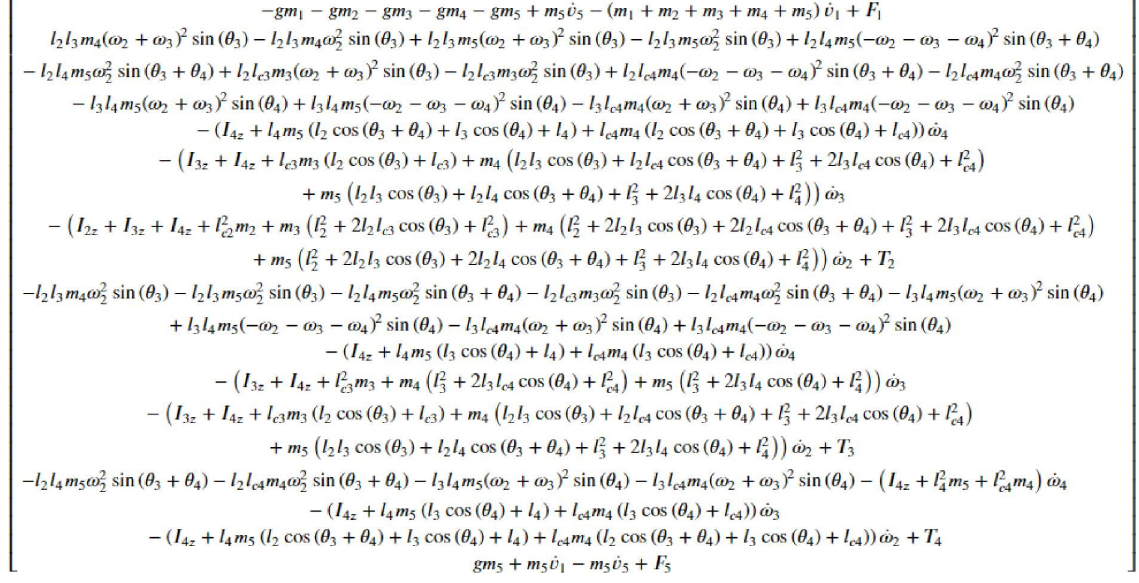
Figure 3: Equations of motion for the 5-DOF SCARA